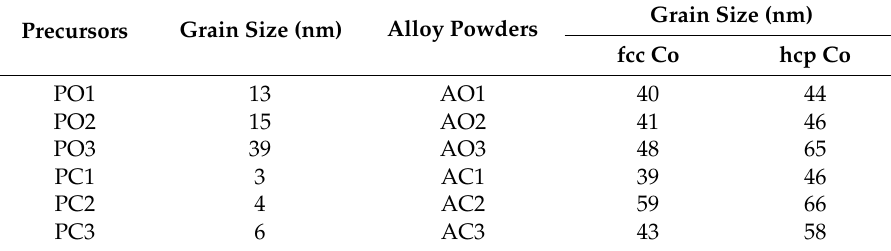
Table 3. Grain sizes of precursors and alloy